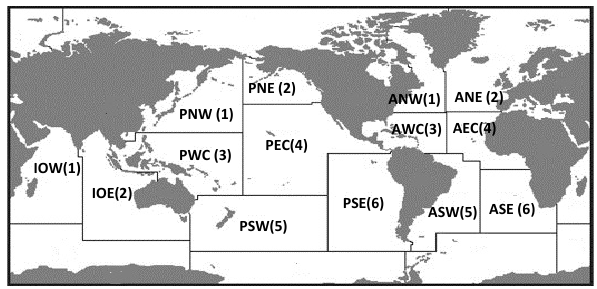
Figure 1. The Food and Agriculture Organization’s (FAO) 14 sub-ocean regions for marine fish species landings in the Pa- cific, Atlantic, and Indian oceans and the 9 groups of marine species tabulated – ocean sub-regions on grey shaded map: Pa- cific, Northwest (PNW); Pacific, Western Central (PWC); Pacific, Southwest (PSW); Pacific, Northeast (PNE); Pacific, Eastern Cen- tral (PEC); Pacific, Southeast (PSE); Atlantic, Northwest (ANW); Atlantic, Western Central (AWC); Atlantic, Southwest (ASW); At- lantic, Northeast (ANE); Atlantic, Eastern Central (AEC); Atlantic, Southeast(ASE); Indian Ocean, Eastern (IOE); Indian Ocean, West- ern (IOW). Nine FAO species groups: (1) Cod, Hakes, Haddocks (CHH), (2) Flounders, Halibut, Soles (FHS), (3) Herrings, An- chovies, Sardines (HAS), (4) Marine Fishes Not Identified (MFNI), (5) Miscellaneous Coastal Fishes (MCF), (6) Miscellaneous De- mersal Fishes (MDF), (7) Miscellaneous Pelagic Fishes (MPF), (8) Sharks, Rays, Chimaeras (SRC), (9) Tunas, Bonitos, Billfishes (TBB). The codes used in the graphics of this paper represent the combination of the FAO geographical ocean sub-regions (shown in this figure) and the fish species categories are listed above (for ex- ample, PNW-CHH is the Pacific Northwest regions’ Cod, Hakes, and Haddocks fish species group). The shortened combined codes (i.e., P21) used in the paper as the x axis identifiers are described in Table A1 of the